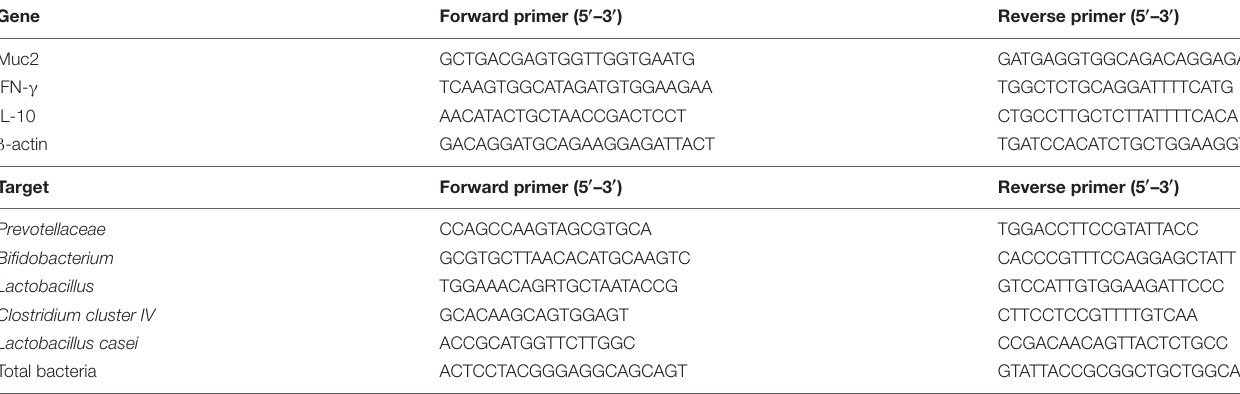
TABLE 1 | Primers used in qPCR